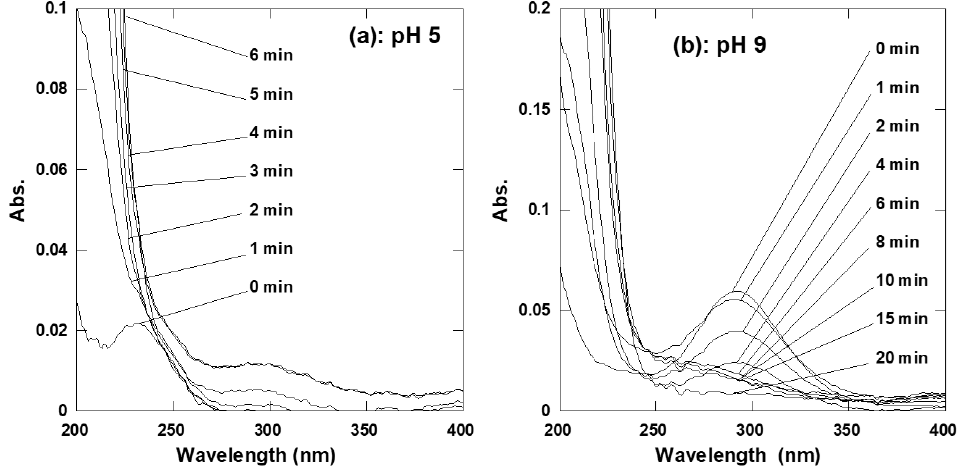
Figure 1. Chlorine sonolysis at pH 5 ( a ) and 9 ( b ) (conditions: [chlorine] 0 = 250 µM, V = 150 mL, temperature: 25 ± 1 °C, frequency: 600 kHz, power: 120 W). temperature: 25 ± 1 ◦ C, frequency: 600 kHz, power: 120